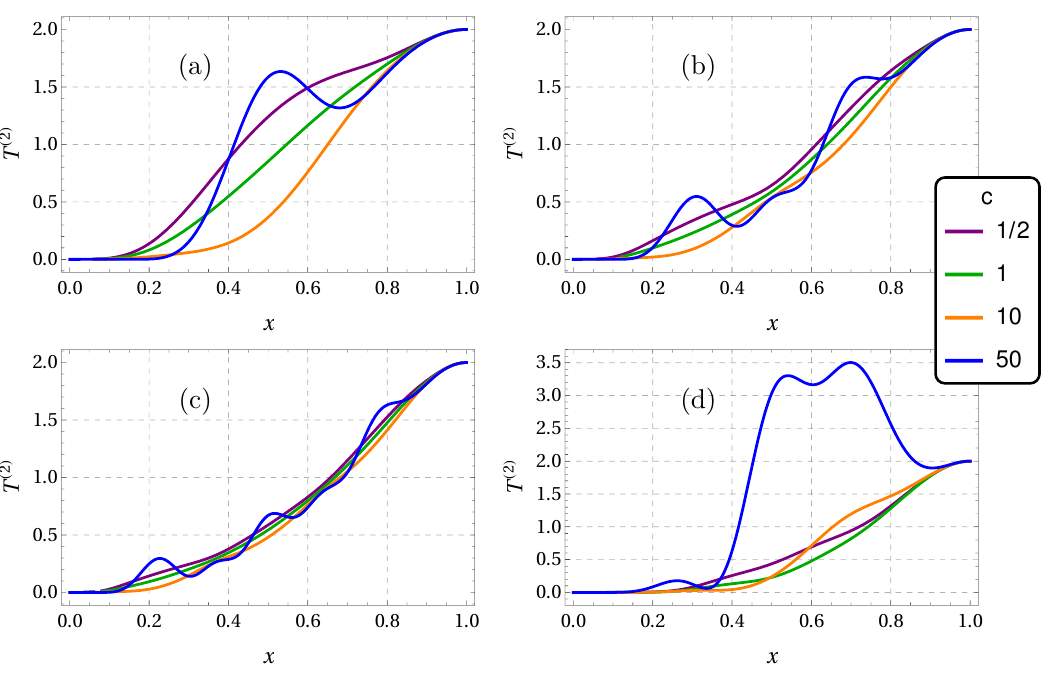
Figure 6 . The Trace Squared Distance between the reduced states of (a) the vacuum and L − 2 | 0 i , (b) the vacuum and L − 3 | 0 i , (c) the vacuum and L − 4 | 0 i , and (d) the states L − 3 | 0 i and L − 2 | 0 i for different values of the central charge c .